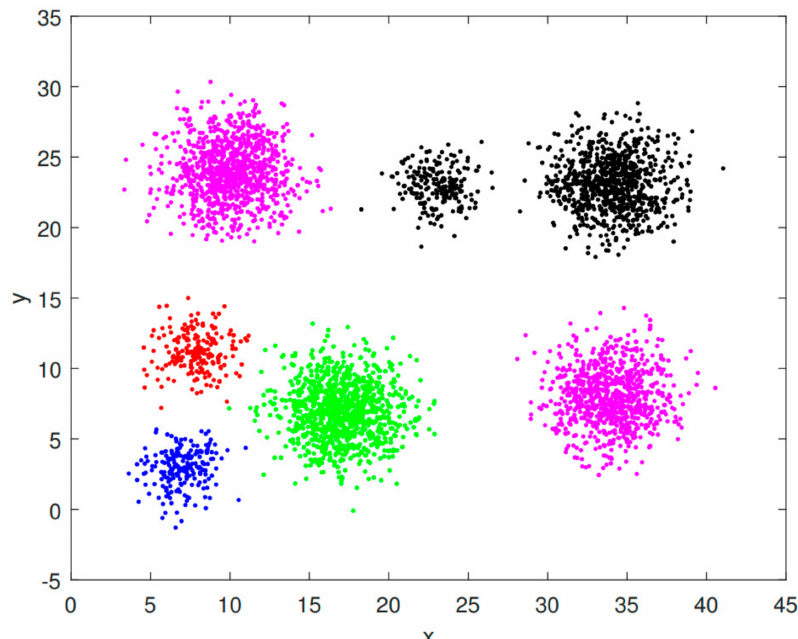
Figure 8. Dataset B plaintext clustering